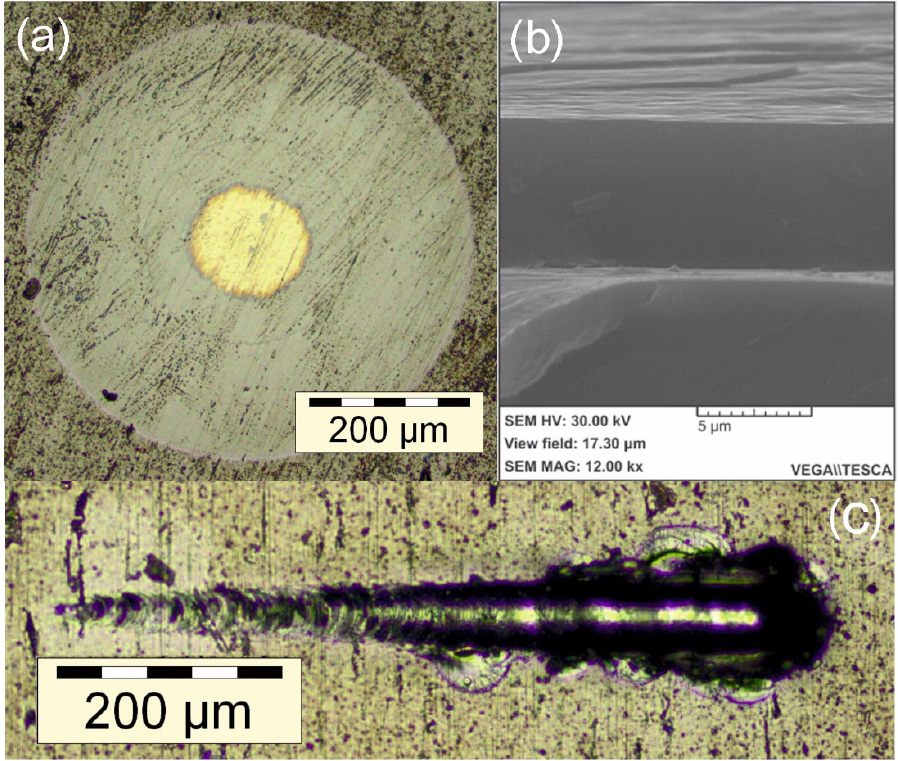
Figure 9. Indentation micrograph ( a ), cross section ( b ) and scratch test optical image ( c ) of TiSiCN